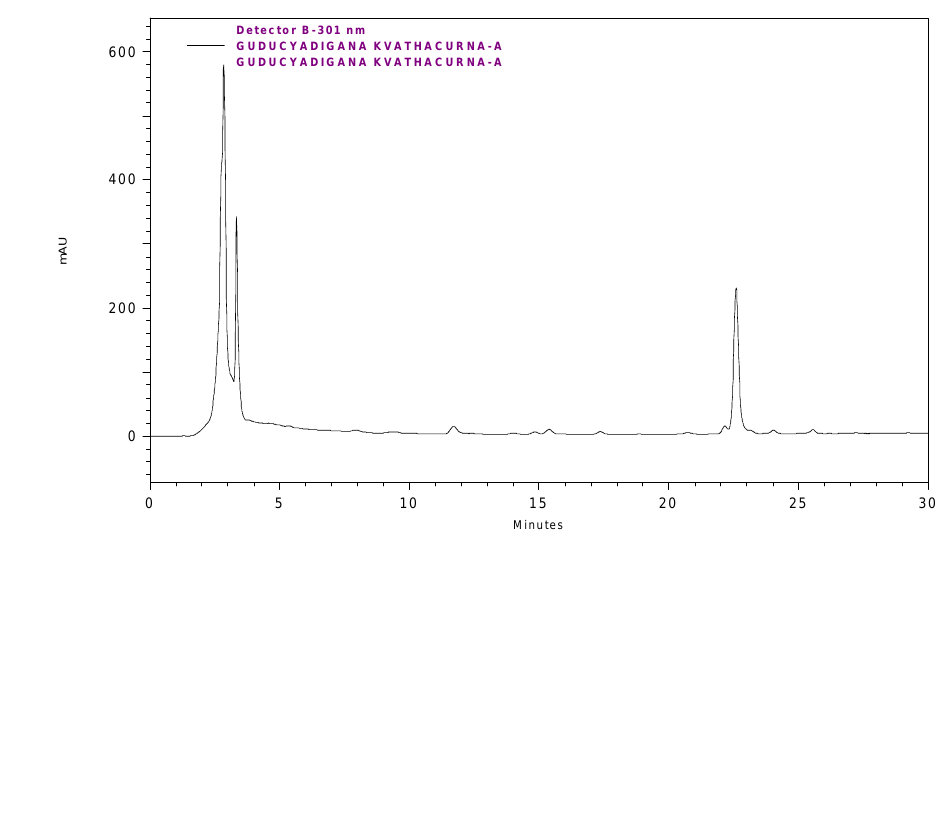
Figure 2. HPLC Chromatogram of Guduchyandigana Kwatha